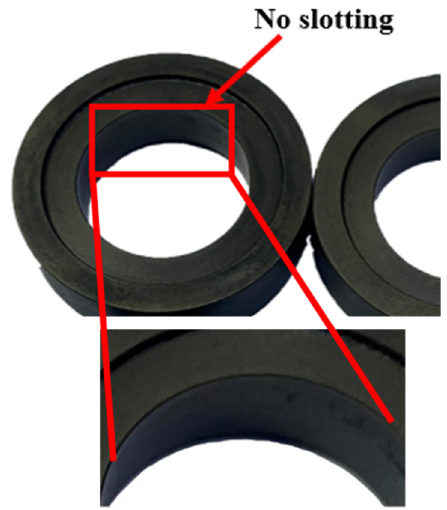
Figure 3. The graphite ring’s appearance.